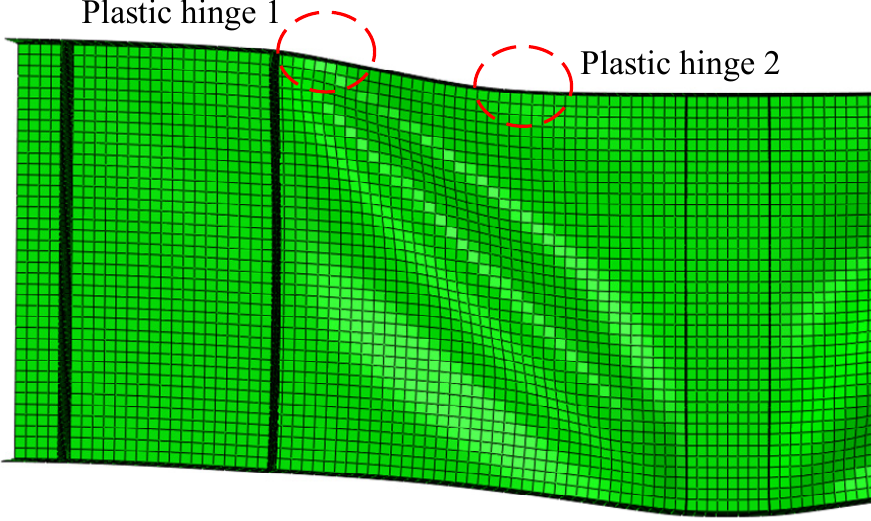
Figure 15. Distribution range of flange plastic hinges.